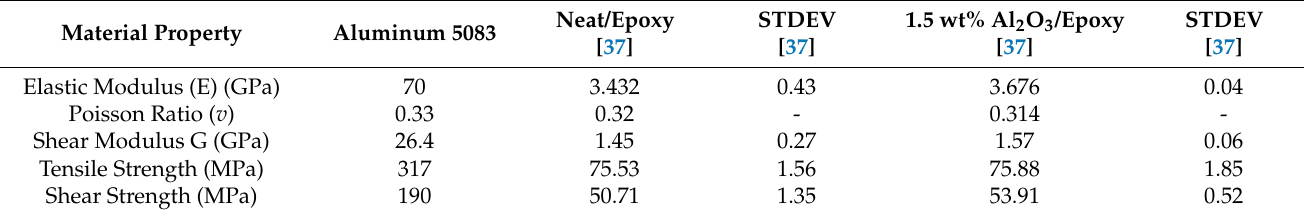
Table 1. Material properties of Al 5083, neat adhesive, and adhesive with Al 2 O 3 nanoparticles.